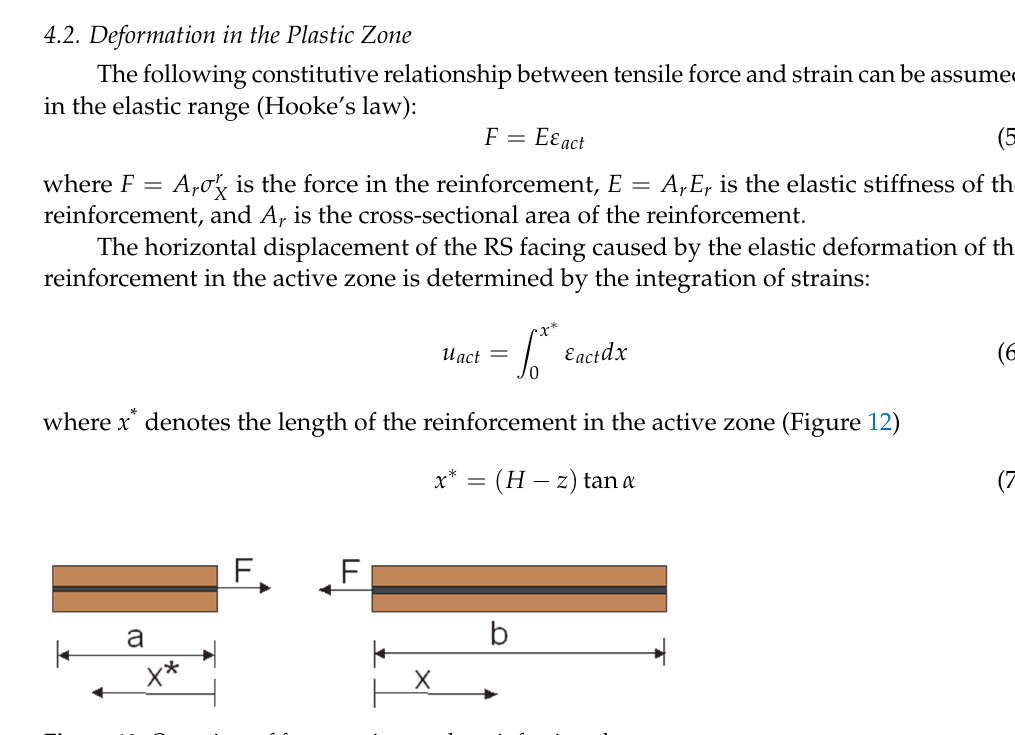
Figure 11. General model of the RS wall ( a ) and equilibrium of the failure wedge ( b ).